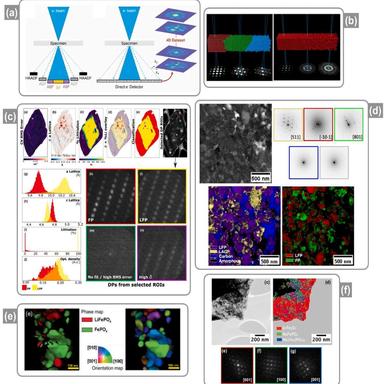
. 4D-STEM techniques: orientation, phase, and strain mappings. (a) Schematics of electron beam interactions with the sample and principles of multiple detection with comparison between HAADF/ADF/ABF/BF STEM detection modes and single detector using direct electron detection for the 4D-STEM approach; (b) Schematics of the 4D-STEM scan on different oriented crystals and on highly crystalline and amorphous areas ; (c) Mapping analysis of 4D-STEM strains of LiFePO4 after partial delithiation, for which lattice